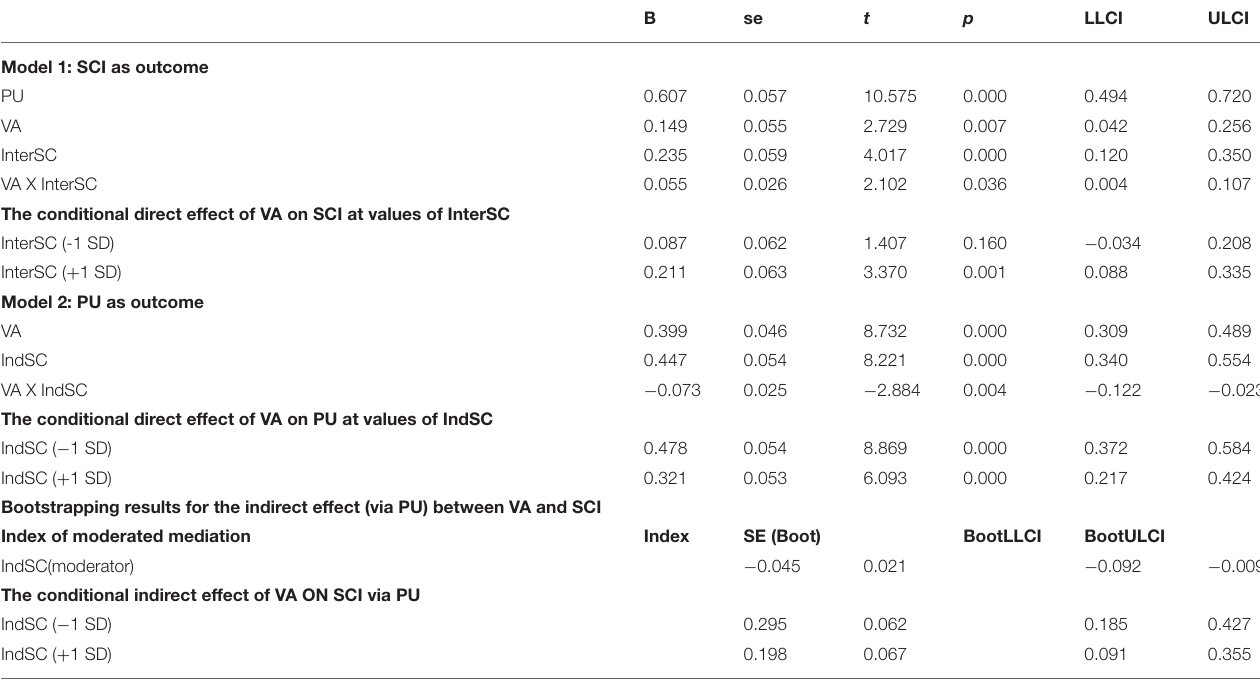
TABLE 4 | Moderated mediation analysis—self-construal (InterSC and IndSC) moderates the direct and indirect relationship between VA and SCI (PROCESS model 8, 95% CI).